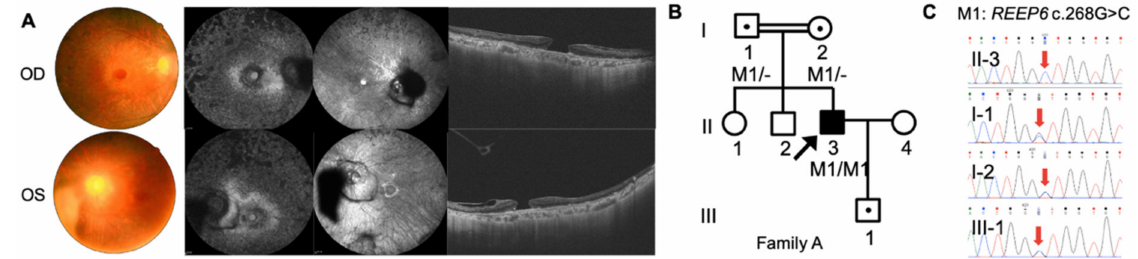
Figure 1. Phenotype and genotype of family A. A homozygous mutation of REEP6 c.268G>C was found in the consan- guineous family. ( A ) Clinical findings of proband A: II-3 including fundus photography, short wavelength AF, IR images and SS-OCT images. ( B ) Pedigree of family A. Black arrows represented the proband. Double lines represented consanguineous. ( C ) Sanger sequencing confirmation of individuals from family